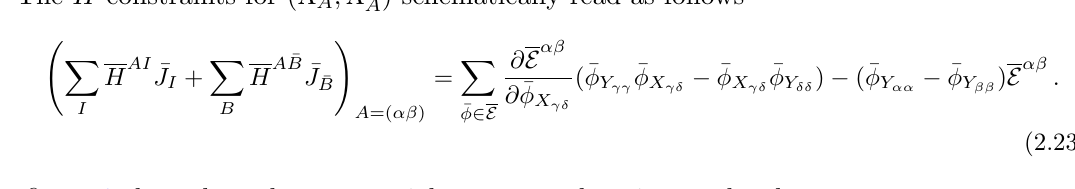
(cid:12)gure 2 shows how the two partial sums cancel against each